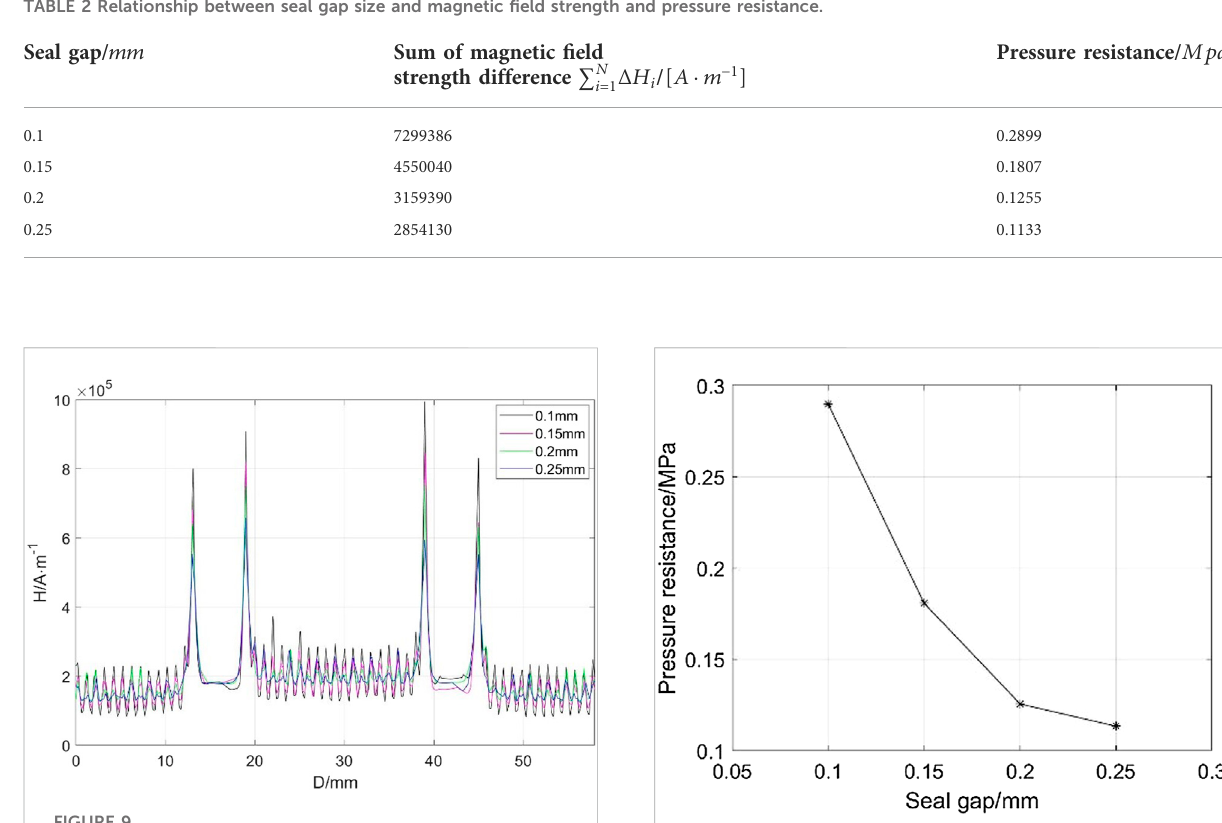
FIGURE 9 Magnetic fi eld distribution under different seal gaps. FIGURE 10